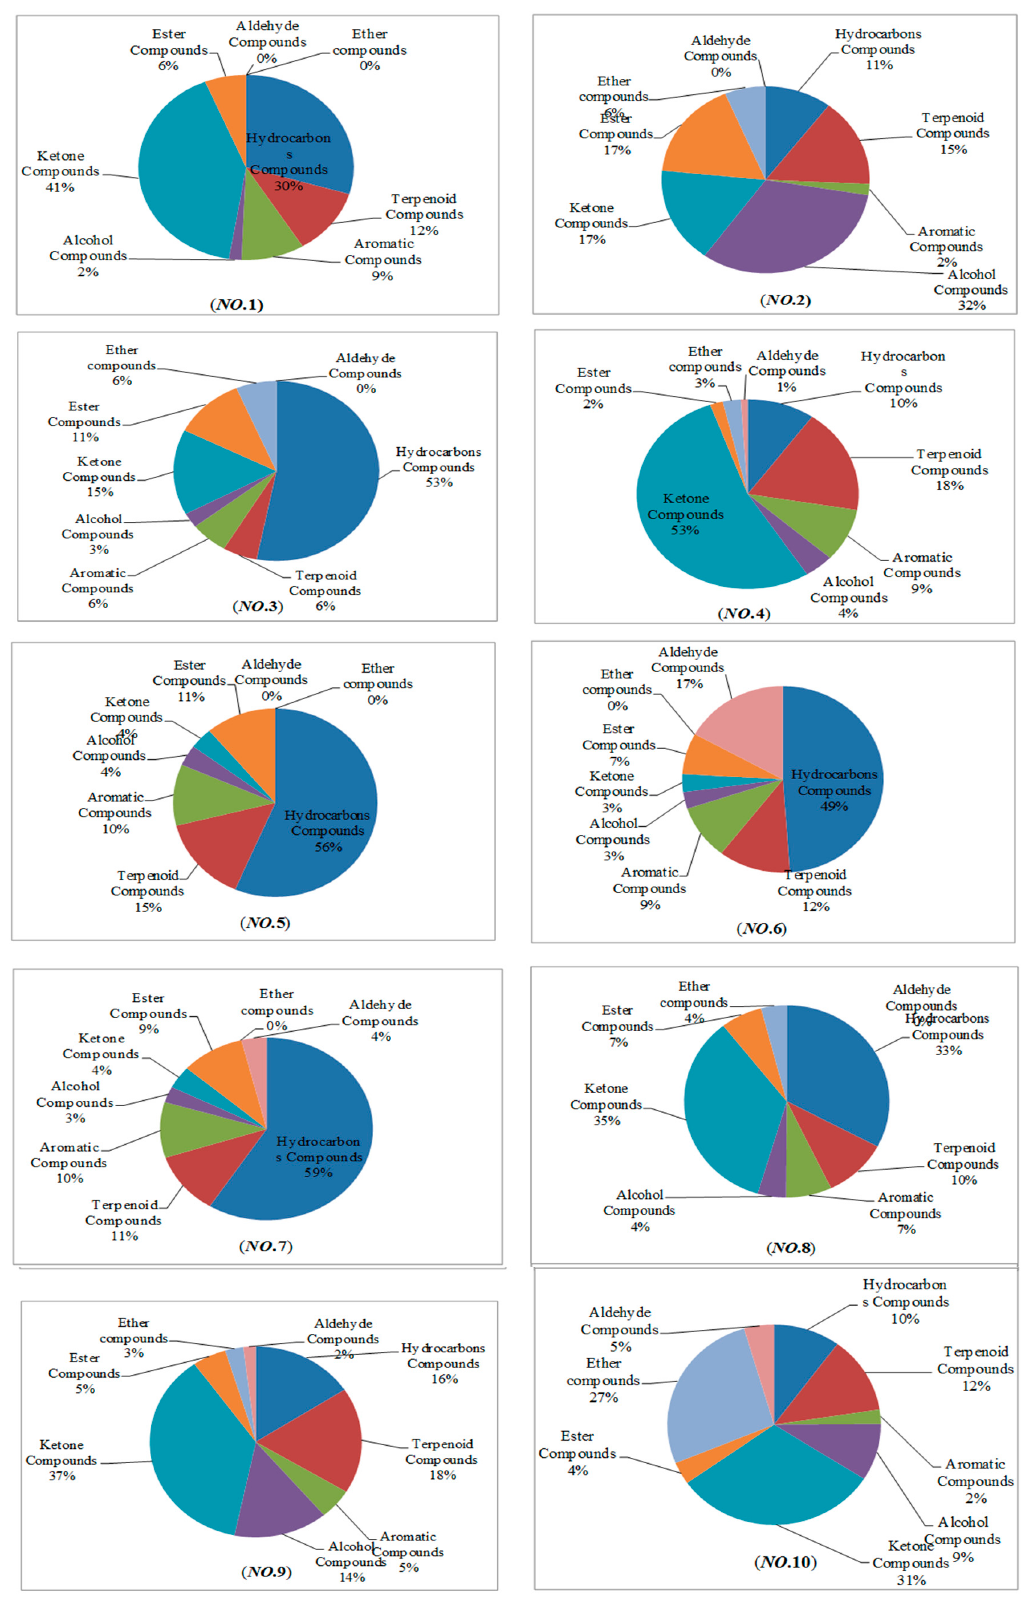
Figure 3. Percentage of terpenoids, hydrocarbons, and other compounds released from fully open Chrysanthemum samples of flowers.